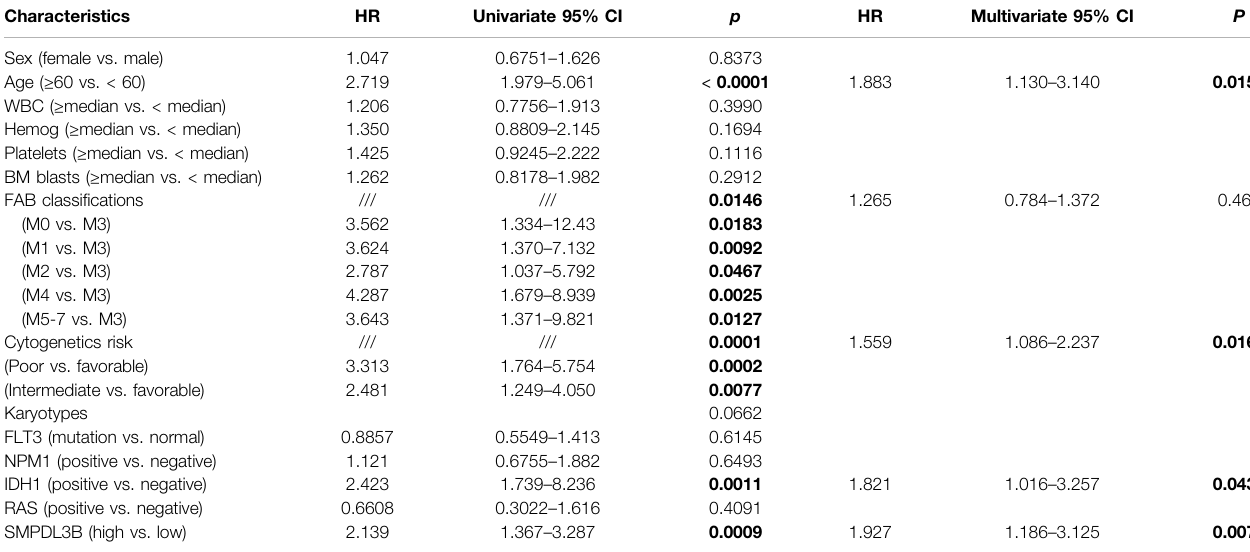
TABLE 2 | Univariate and multivariate Cox regression analysis of overall survival in AML patients.